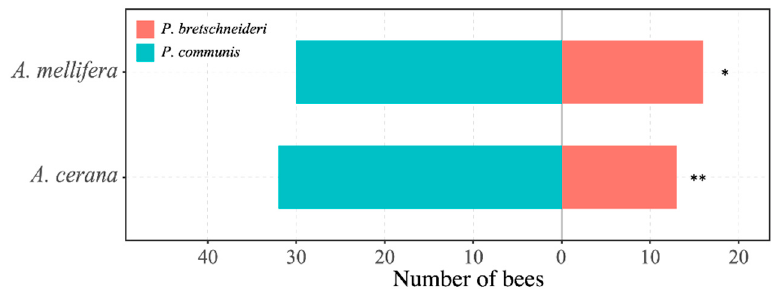
Figure 4. Choices of honey bees regarding different pear flower volatiles according to Y-tube olfac- tometer tests (*: 0.01 < p < 0.05, **: 0.001 < p < 0.01). tometer tests (*: 0.01 < p < 0.05, **: 0.001 < p <